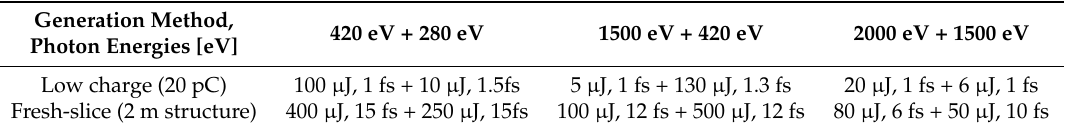
Table 2. Estimated performance of low-charge and fresh-slice methods for generating two-color SASE radiation for three different combinations of photon